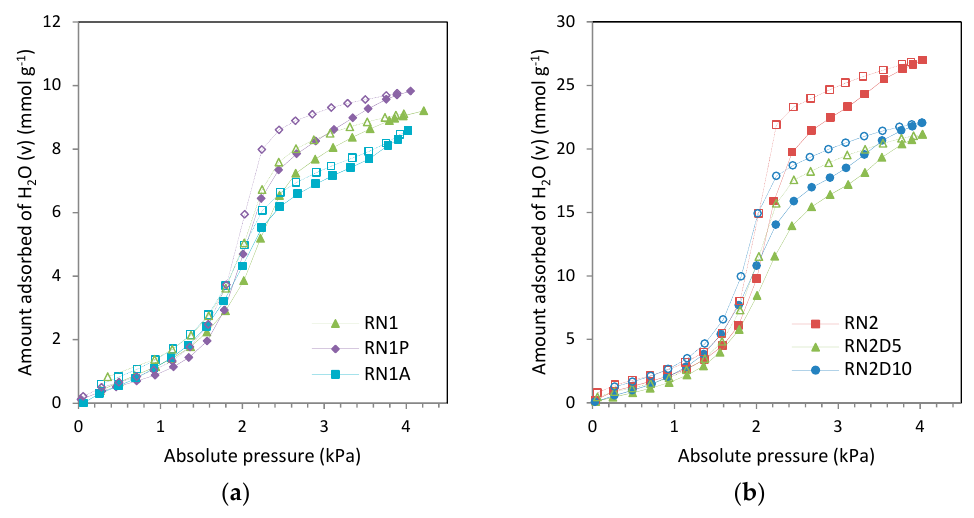
Figure 3. Water vapor adsorption isotherms at 30 °C: ( a ) RN1, RN1P, and RN1A; ( b ) RN2, RN2D5, and RN2D10 (full symbols and continuous lines correspond to the adsorption branch, and empty symbols and dashed lines to the desorption branch).